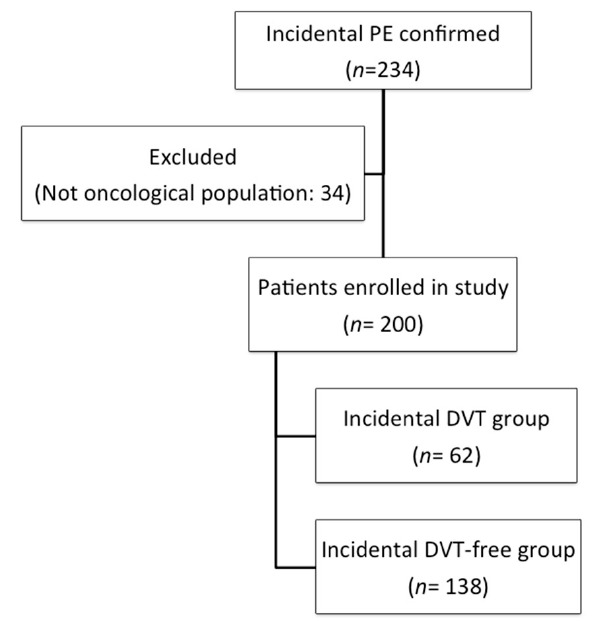
Figure 1. Flow diagram. Abbreviations: DVT: deep vein thrombosis; PE: pulmonary embolism. Table 1. A comparison of baseline characteristics in the deep vein thrombosis (DVT) and DVT-free groups.